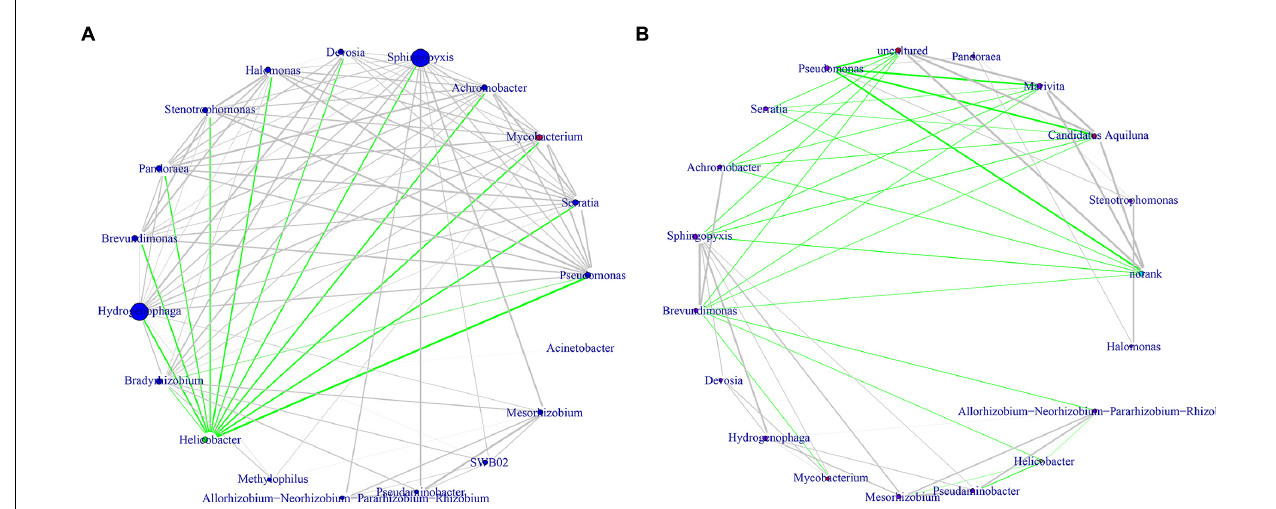
FIGURE 5 | Correlation strengths of the abundant gastric microbiota in different stomach microhabitats from children with duodenal ulcer. Correlation network of the abundant gastric microbiota in H. pylori -positive group (A) and H. pylori- negative group (B) . The genera were connected (Gray: positive correlation; Green: negative correlation) when the pair-wise correlation values were significant ( P < 0.05) after adjusting the P -values for multiple comparisons. Furthermore, sub-community detection was performed by placing the genera in the same sub-community (represented by the color of nodes) when many links were found at correlation values > 0.6 between members of the